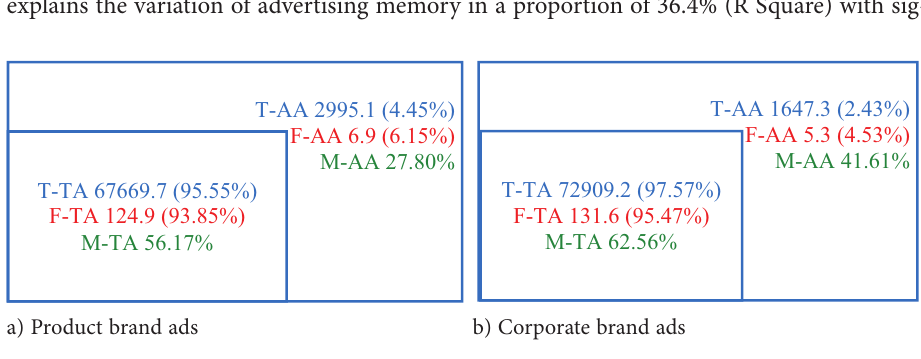
Figure 3. Visual representation of H3 and H4 by average fixation Time (T), average Fixation count (F) and short-term Memory (M) on Task Area (TA) and Advertising Area